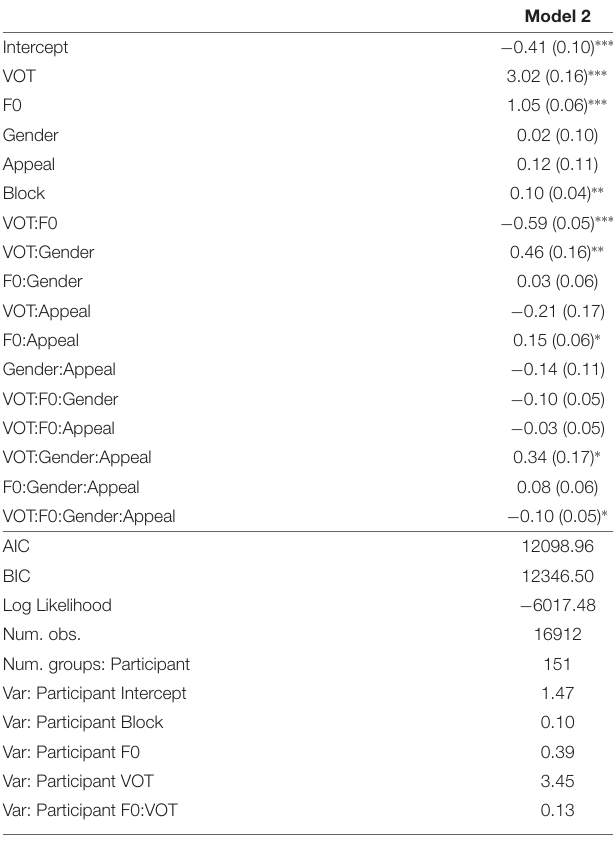
signs of the principal components were reversed before entering the model for ease of interpretation (e.g., the higher the PC1 value of the visual impression ratings, the greater the visual appeal). Model selection started with the maximal model with all possible interactions between fixed factors (the impression rating attributes do not interact with each other, however),